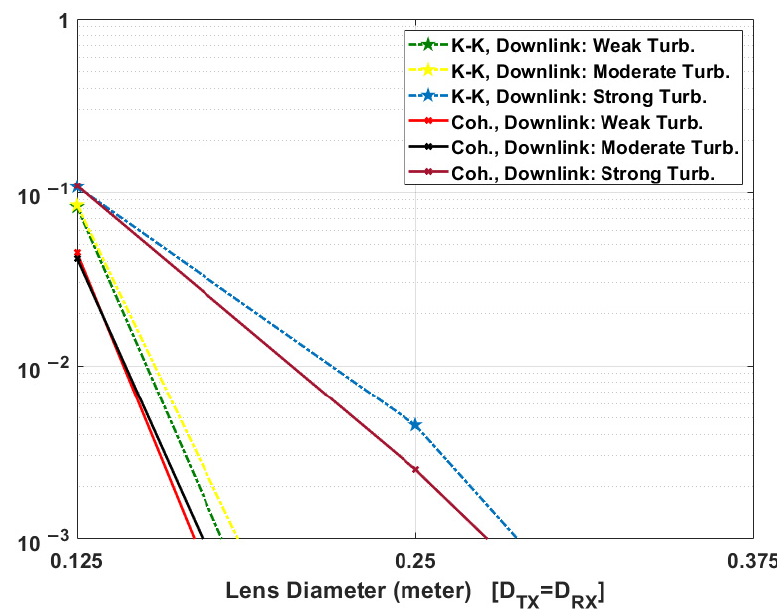
Figure 9. Comparison between KK and coherent transceiver downlink performance in the presence of scintillation versus telescopes lens diameter (Tx/Rx amplifier gains are 30 dB, Tx/Rx lens diameters are assumed equal. Also, please see C 2 n ( 0 ) values in Table 1 for weak, moderate, and strong turbulence.